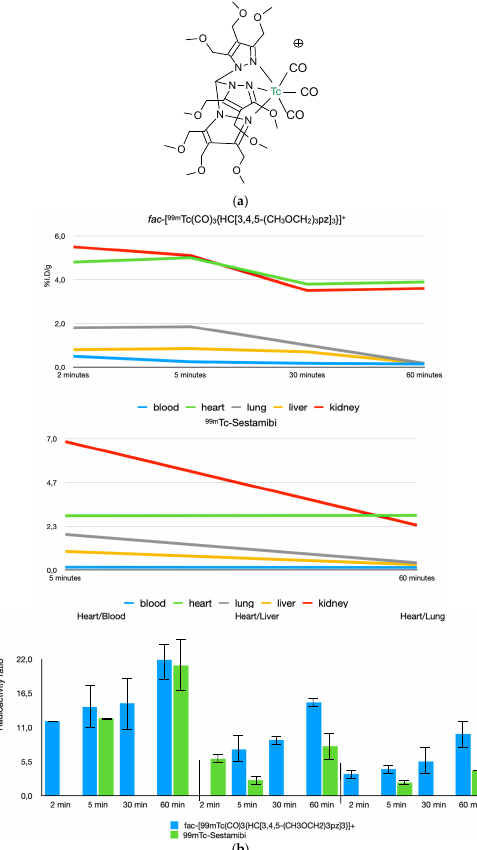
+ ( a ) and biodistribu-